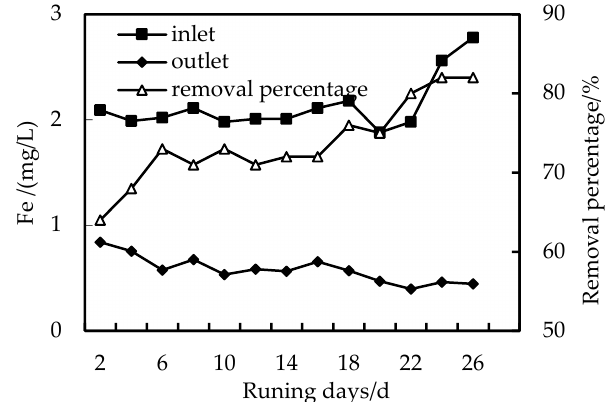
Figure 9. Removal of Fe with HUM.